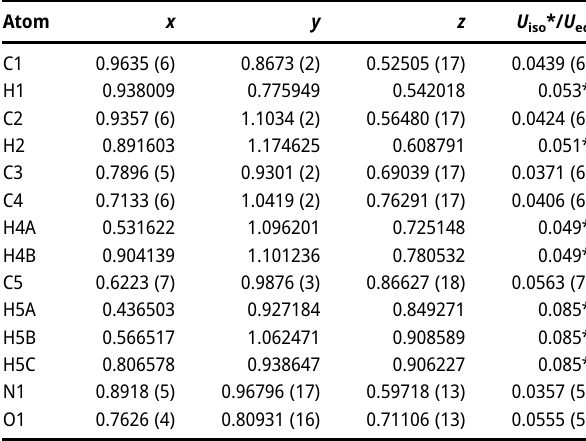
Table  : Fractional atomic coordinates and isotropic or equivalent isotropic displacement parameters (Å 